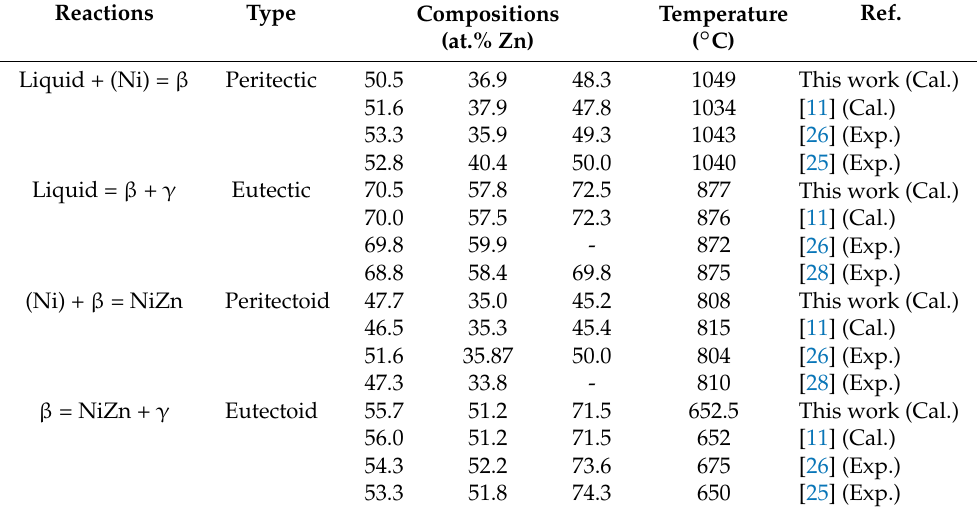
Table 2. List of the invariant reactions related to the β phase, calculated according to the presently obtained thermodynamic parameters, compared to the literature data [11,25,26,28].